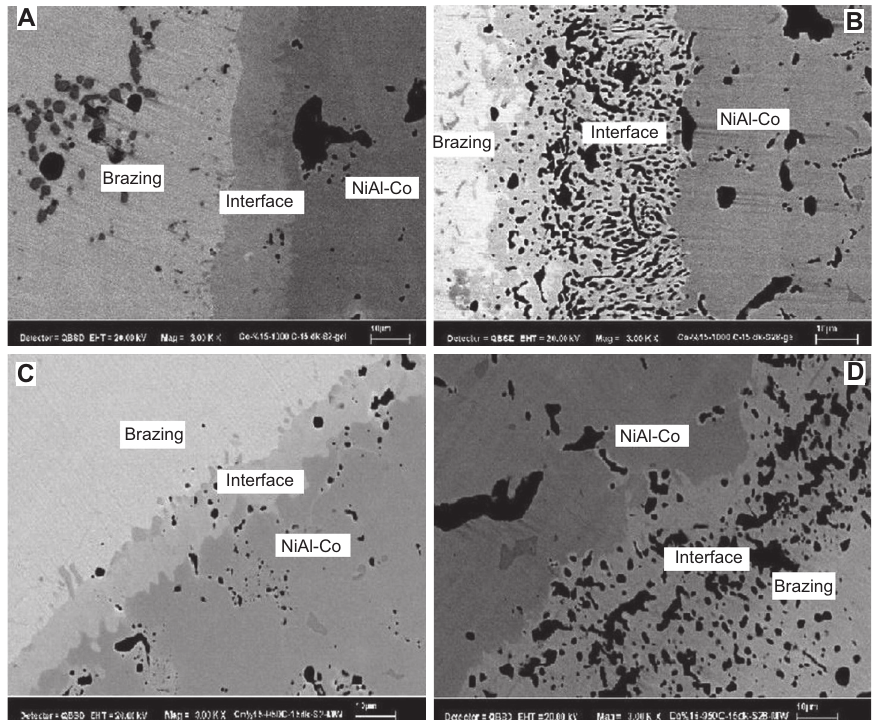
Figure 7 SEM images from Ni+Al+% 15 Co brazed for 15 min. (A) Braze-composite interface in a traditional furnace with a S2 brazing alloy; (B) braze-composite interface in a traditional furnace with a S28 brazing alloy; (C) braze-composite interface in a microwave furnace with a S2 brazing alloy; (D) braze-composite interface in a microwave furnace with a S28 brazing